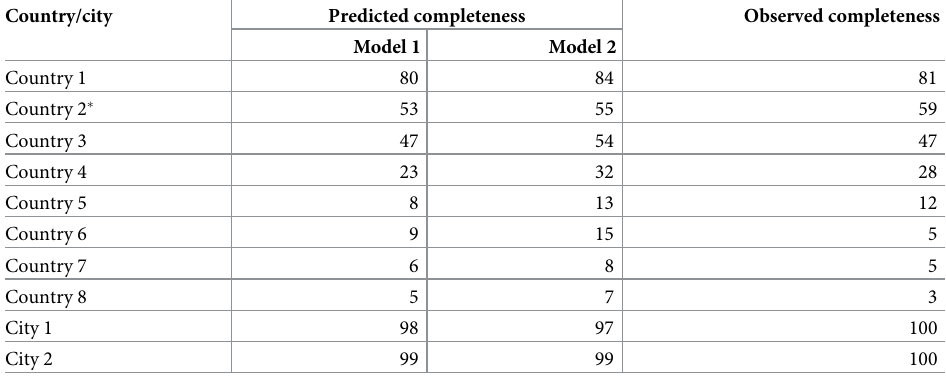
(33%). For most departmentos , a one standard error change in 5q0 changes predicted com- pleteness a few percentage points in each direction; the average change for Model 1 is ± 5 per- centage points (maximum of 10) and for Model 2 is ± 3 percentage points (maximum of 6).